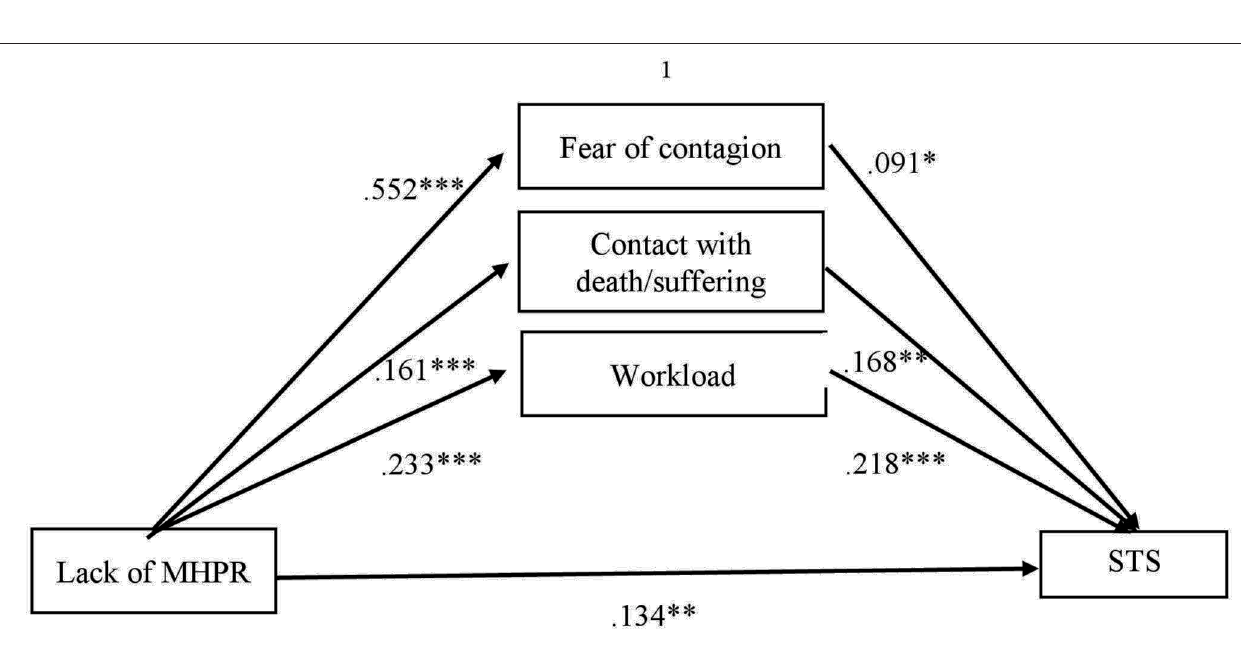
FIGURE 3 | Mediational effects of job demands on lack of MHPR in predicting Secondary Traumatic Stress (STS). MHPR, Material and Human Protection Resources; STS, Secondary Traumatic Stress. 1 Total indirect effect of lack of MHPR on STS through all job demands ( β = 0.139; t = 2.976; p < 0. 01). * p < 0.05; ** p < 0.01; *** p <